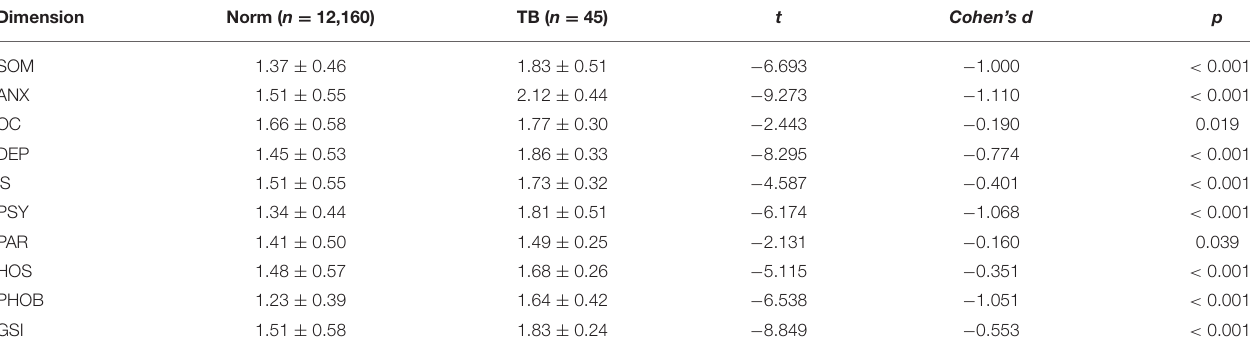
TABLE 4 | SCL-90 scores (mean ± SD).